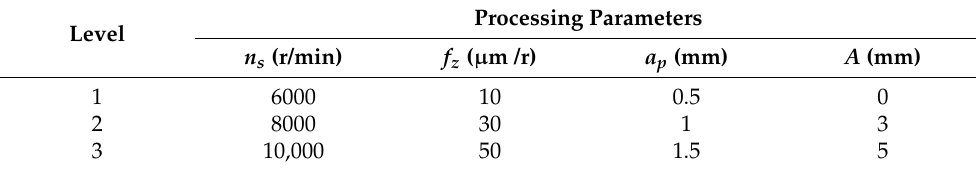
Table 3. Orthogonal test scheme.